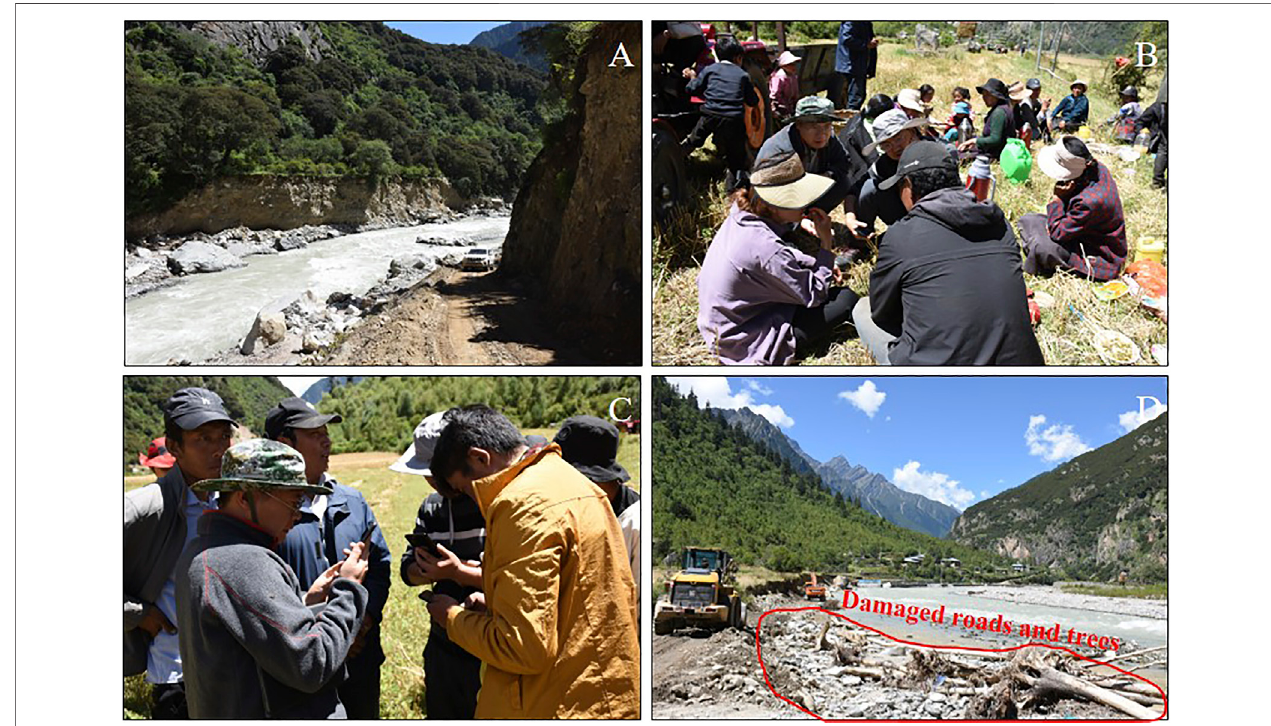
FIGURE 2 | (A) The road beside the river between the Zhongyu town and the JGL. (B) On-site interview with residents. (C) Researchers were watching videos of the outburst provided by residents. (D) The scene after being washed away by the fl ood.